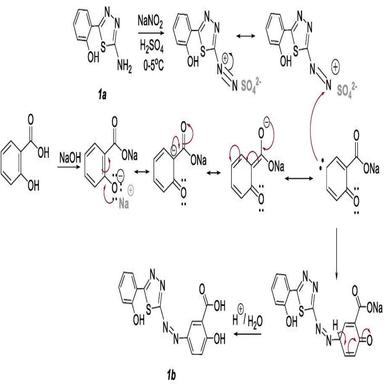
The color change of dye (1b) from red (a) to yellow (b) due to dye protonation.